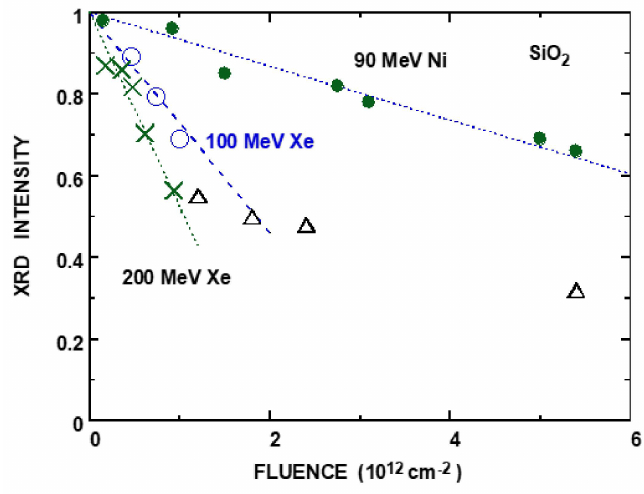
Figure 1. XRD intensity from (002) diffraction plane at ~22 ◦ normalized to as-grown films of SiO 2 as a function of ion fluence for 90 MeV Ni ( • ), 100 MeV Xe (o, ∆ ) and 200 MeV Xe (x) ions. Data of 90 MeV Ni ( • ) and 100 MeV Xe ( ∆ ) are from [70]. Linear fit is indicated by dashed lines. An estimated error of XRD intensity is 10%.